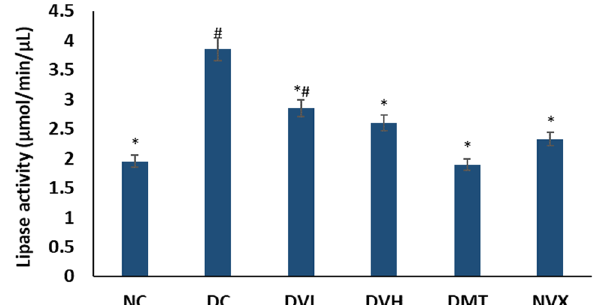
Figure 8. Lipase activities of experimental groups. Value = mean ± SD; n = 5. *Statistically significant ( p < 0.05) to DC; #Statistically significant ( p < 0.05) to NC. NC = normal rats, DC = diabetic control, DVL = diabetic rats + vanillin (150 mg/kg b.w), DVH = diabetic rats + vanillin (300 mg/kg bw), DMT = diabetic rats + metformin (200 mg/kg b.w), and NVX = normal rats + vanillin (300 mg/kg bw).